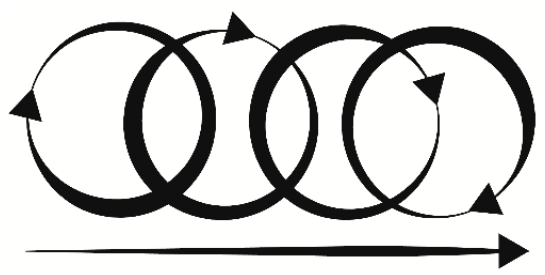
Figure 2. Stimulation pattern with circular and linear components.